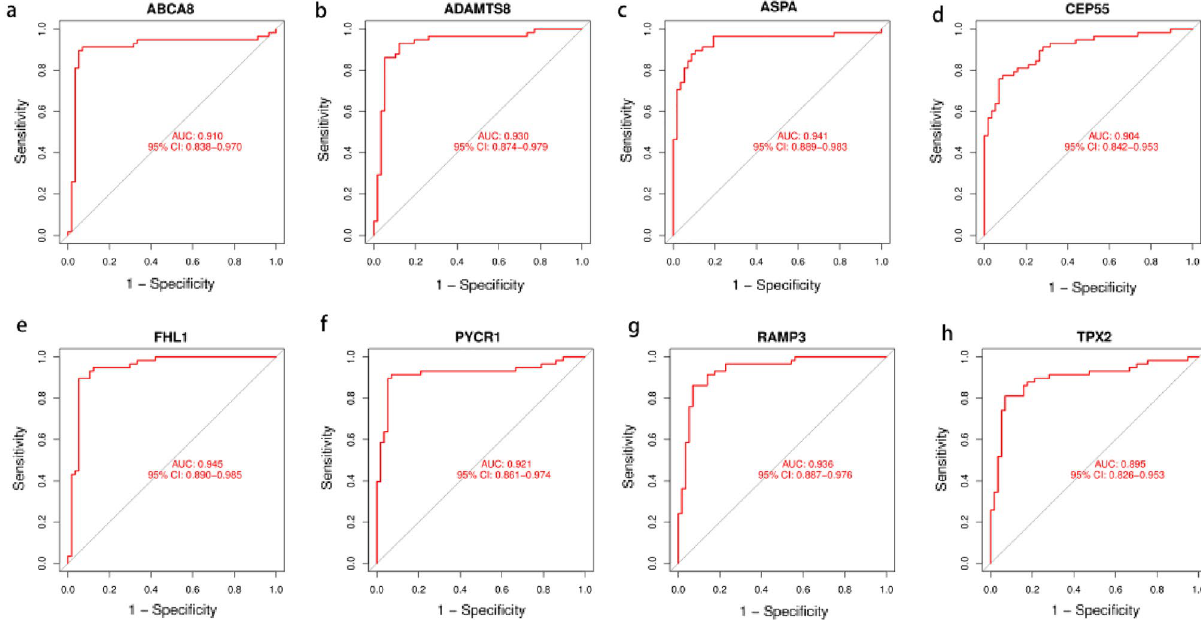
Figure 7. ROC curves for eight biomarkers in the validation dataset (GSE32863). ( a ) ABCA8. ( b ) ADAMTS8. ( c ) ASPA. ( d ) CEP55. ( e ) FHL1. ( f ) PYCR1. ( g ) RAMP3. ( h )